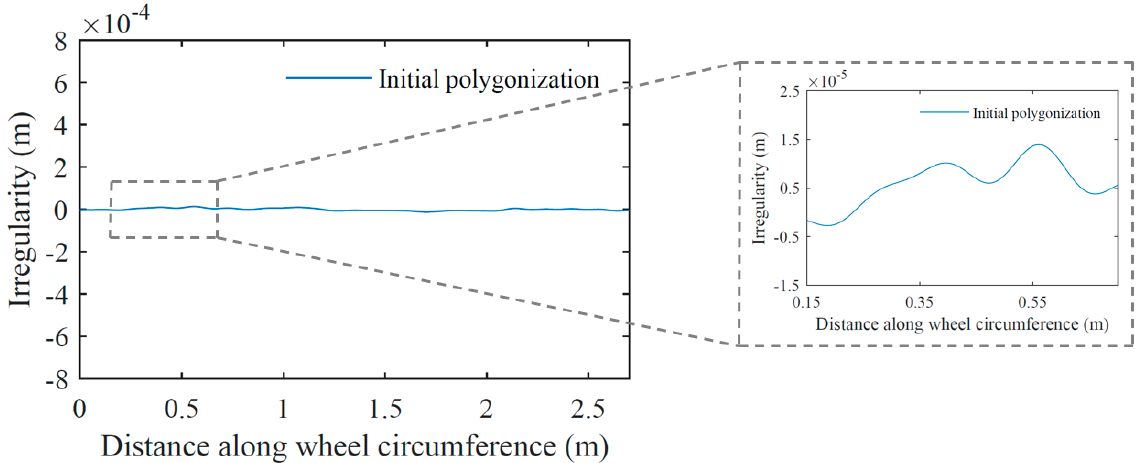
Figure 7. Example of an initial polygonization profile based on Figure 6a irregularity spectrum.